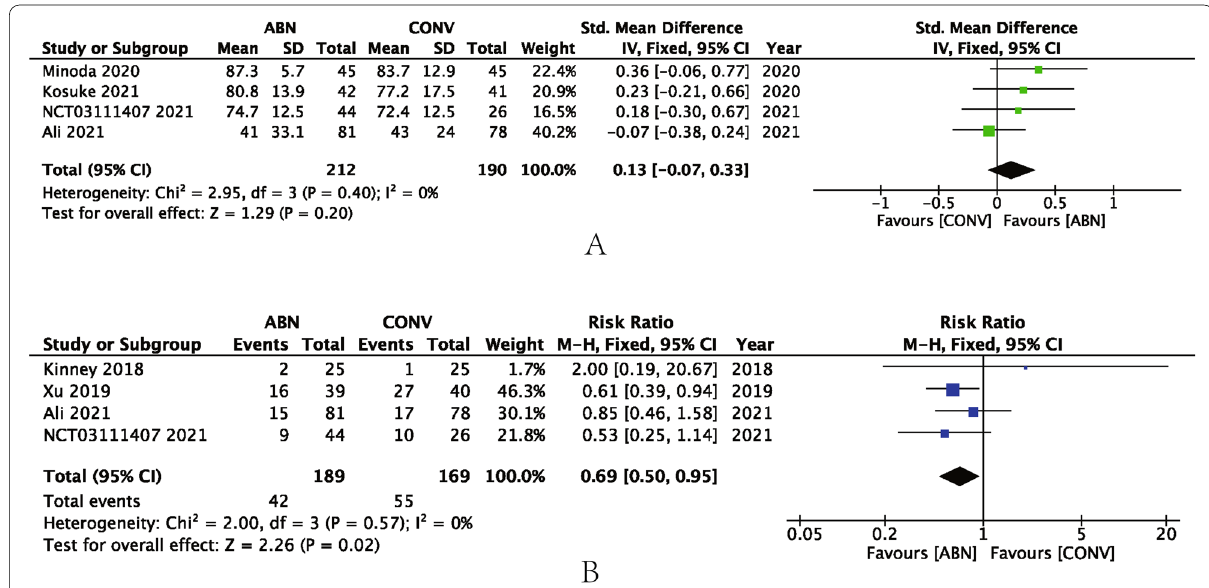
Fig. 8 A Forest plot of PROMs; B Forest plot of overall